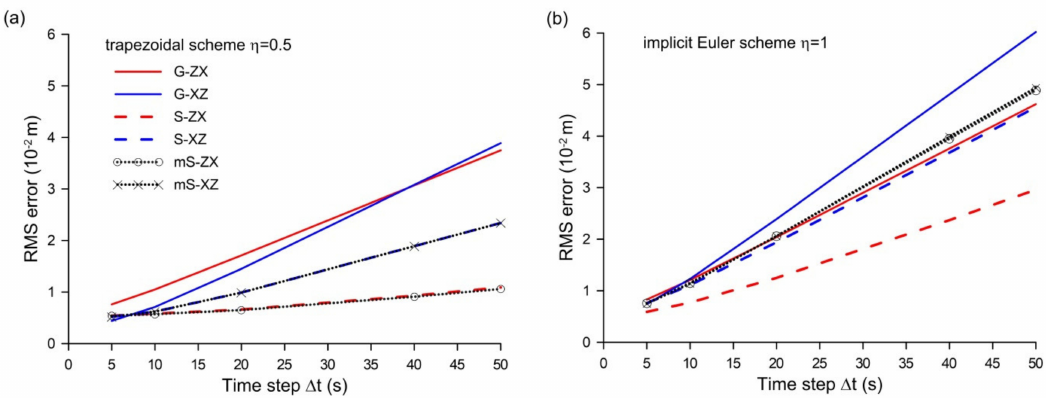
Figure 7. Dependence of the root mean square (RMS) error on the time step ∆ t for various splitting algorithms with the implicit trapezoidal scheme ( η = 0.5) ( a ); the implicit Euler scheme ( η = 1) ( b